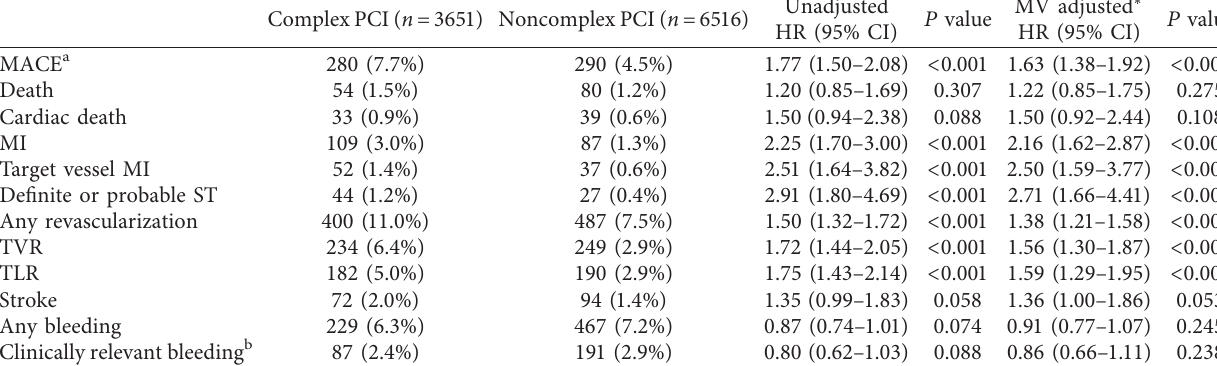
Table 2: Clinical outcomes according to PCI